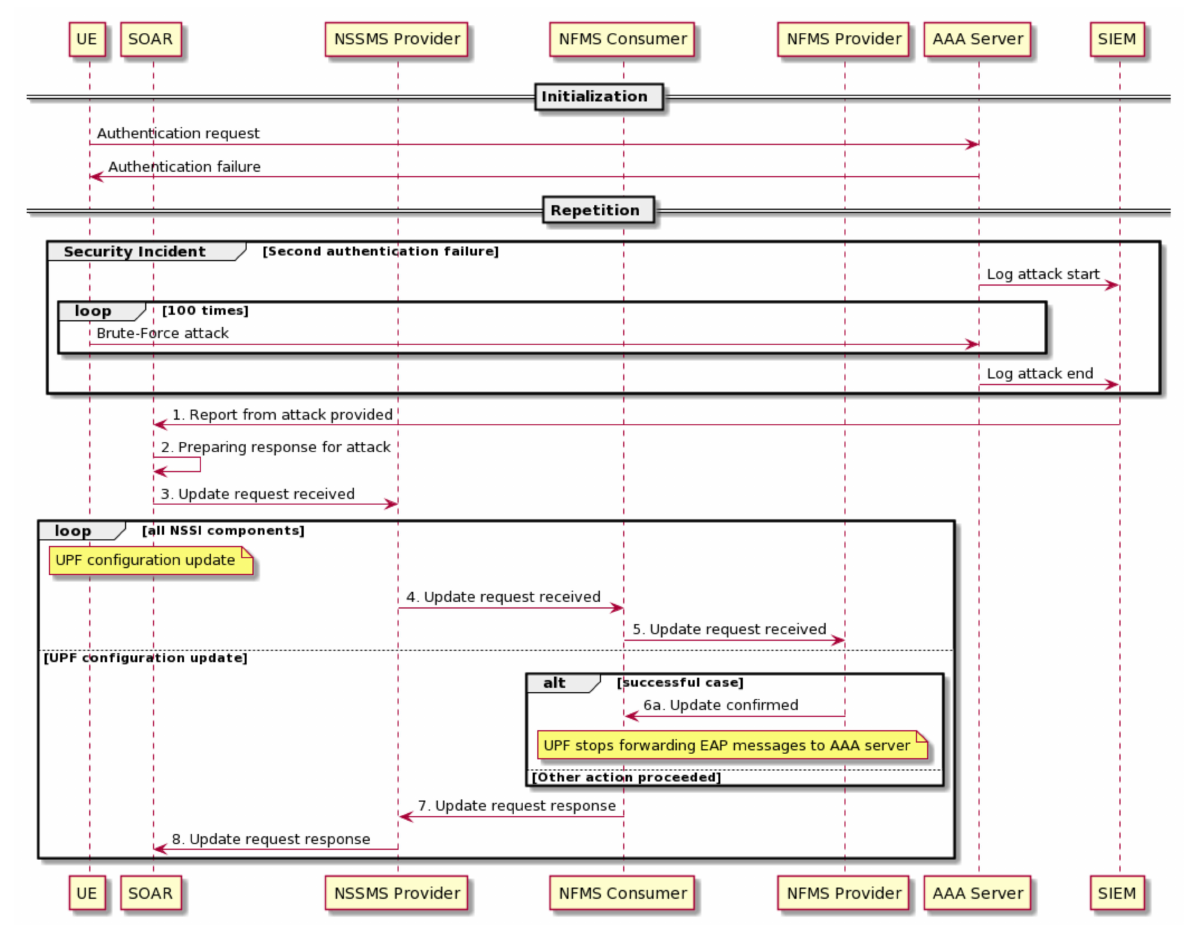
Figure 14. Response procedure to the brute-force secondary authentication